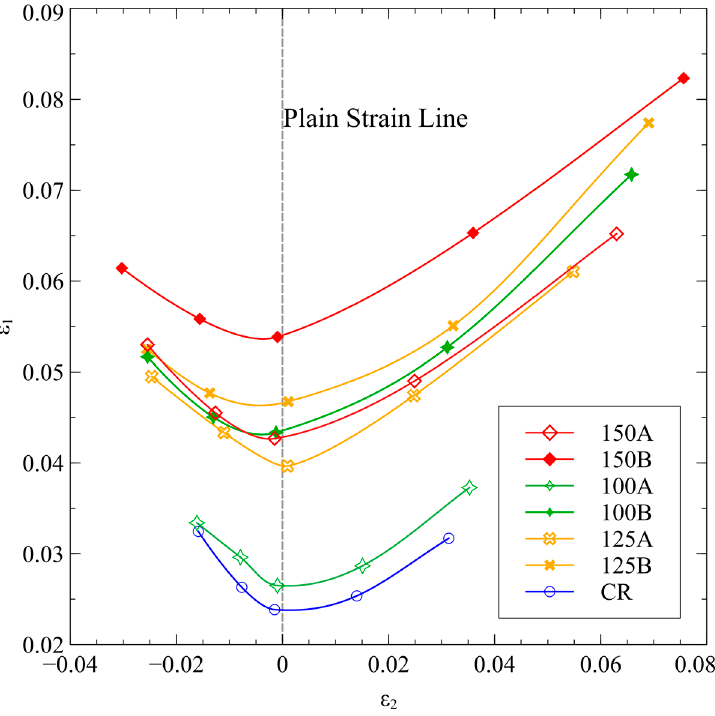
Figure 7. The forming limit diagram for different aging treatments of Aluminum Alloy 6061.